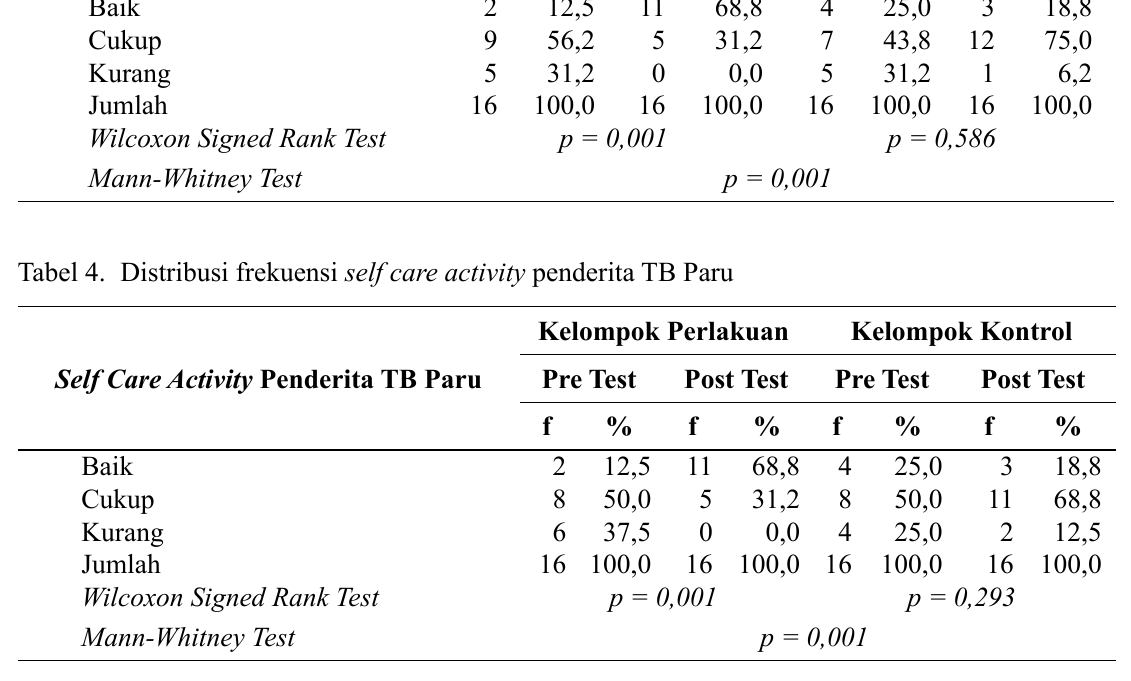
Self Ef fi cacy Penderita TB Paru